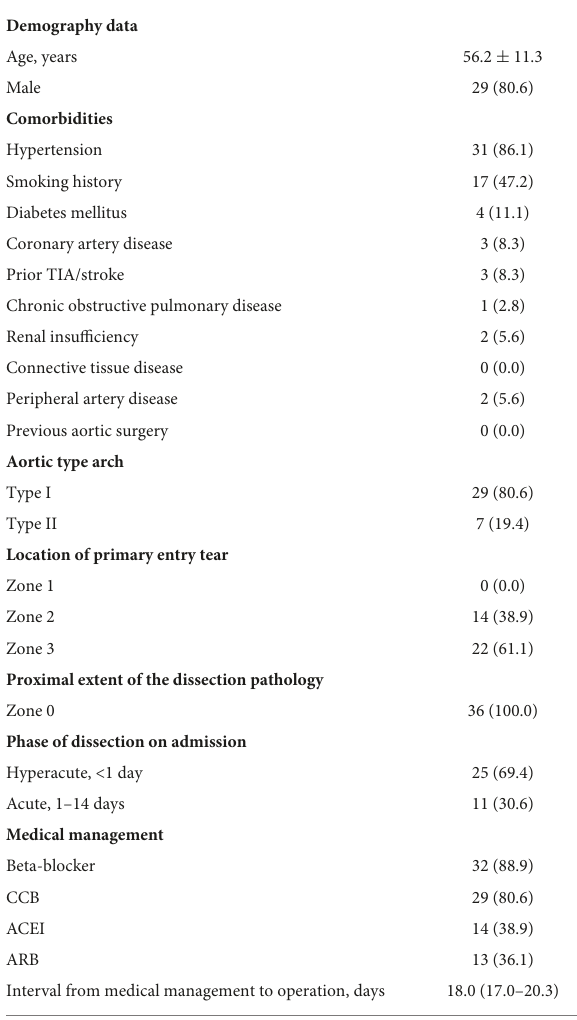
TABLE 1 Baseline characteristics and pre-operative medical